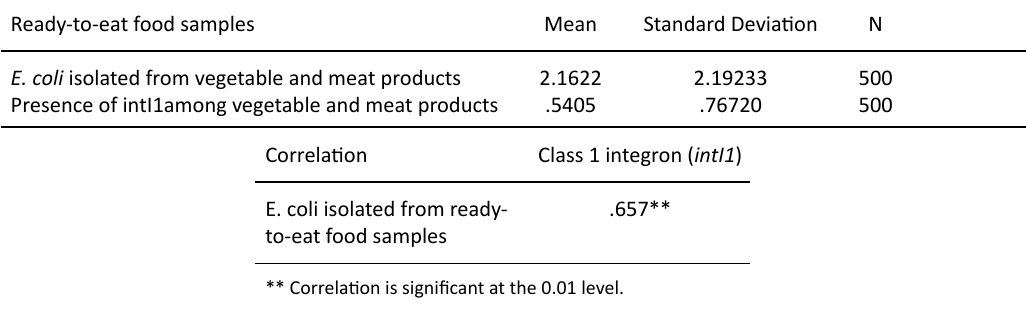
table 4. Statistical analysis between ready-to-eat foods and class 1 integron Ready-to-eat food